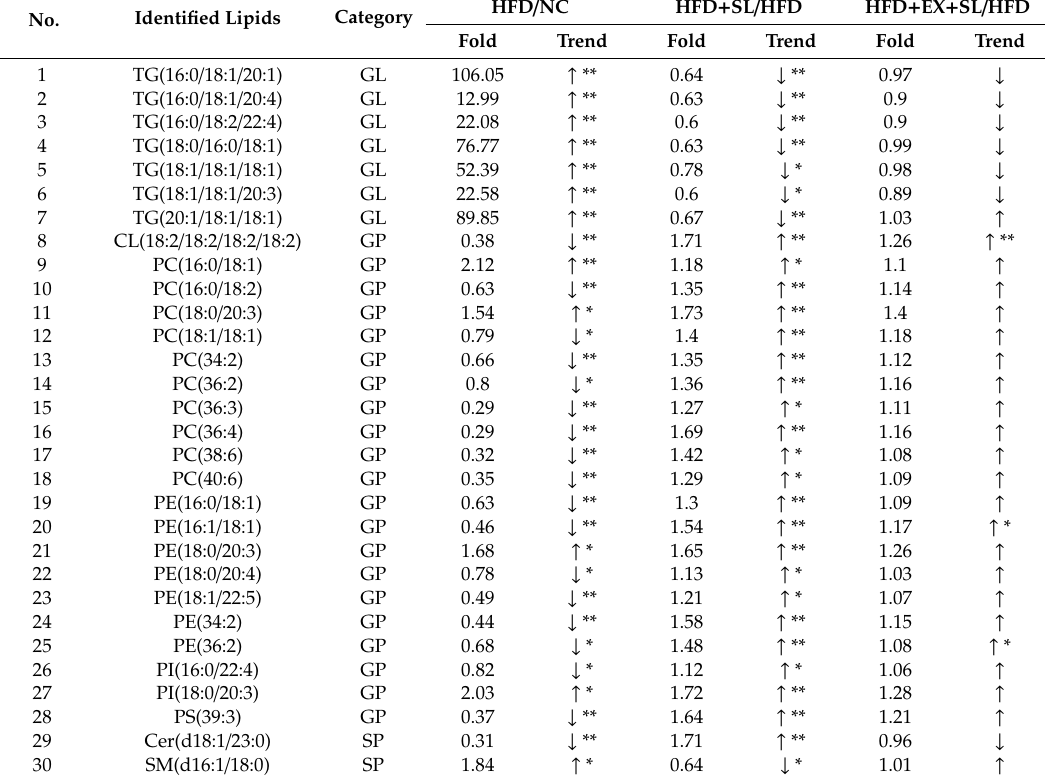
Figure 6. Intensities of representative differential lipid species of the five groups. ** p < 0.01, compared with NC group; # p < 0.05, ## p < 0.01, compared with HFD group.